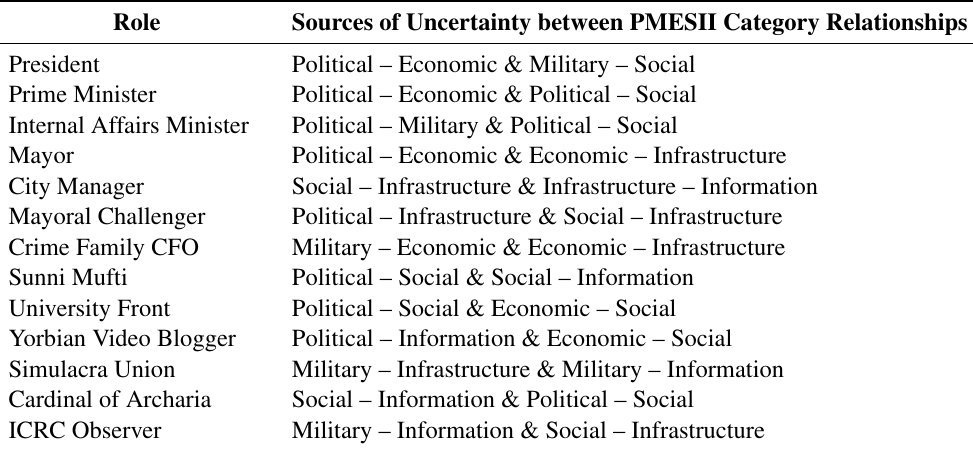
Listing of role-based identification of critical uncertainties.